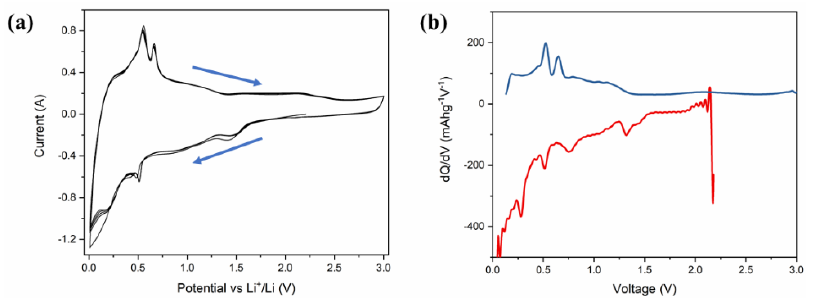
Figure 5. Electrochemical performance of δ -CsPbI 3 active materials in Li-ion half-cell. ( a ) Cyclic voltammetry trace of a δ -CsPbI 3 half-cell within a voltage window of 0.1–3.0 V, recorded at a scan rate of 0.1 mV s –1 . ( b ) Incremental capacity dQ/dV vs. cell potential as recorded at a rate of 40 mA g − 1 for first electrochemical cycle.